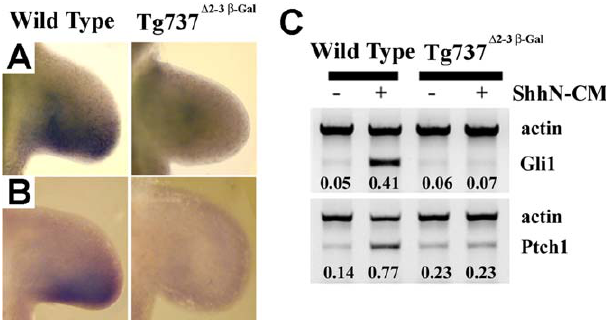
Figure 2. Shh Signaling Is Defective in Tg737 D 2–3 b -gal Mutants (A and B) In situ hybridization analysis of Ptch1 (A) and Gli1 (B) expression indicates that they are not expressed in the posterior limb buds of Tg737 D 2–3 b -gal mutant embryos (E10.5; right panels) as they are in wild- type controls (E10.5, left panels). (C) Incubation of wild-type limb bud cells with ShhN-CM results in upregulation of Gli1 and Ptch1 expression (left lanes) compared to vector conditioned medium, whereas no increase is seen in cells isolated from Tg737 D 2–3 b -gal mutant limb buds (right lanes). The relative levels of induction standardized to actin are indicated below each lane. DOI: